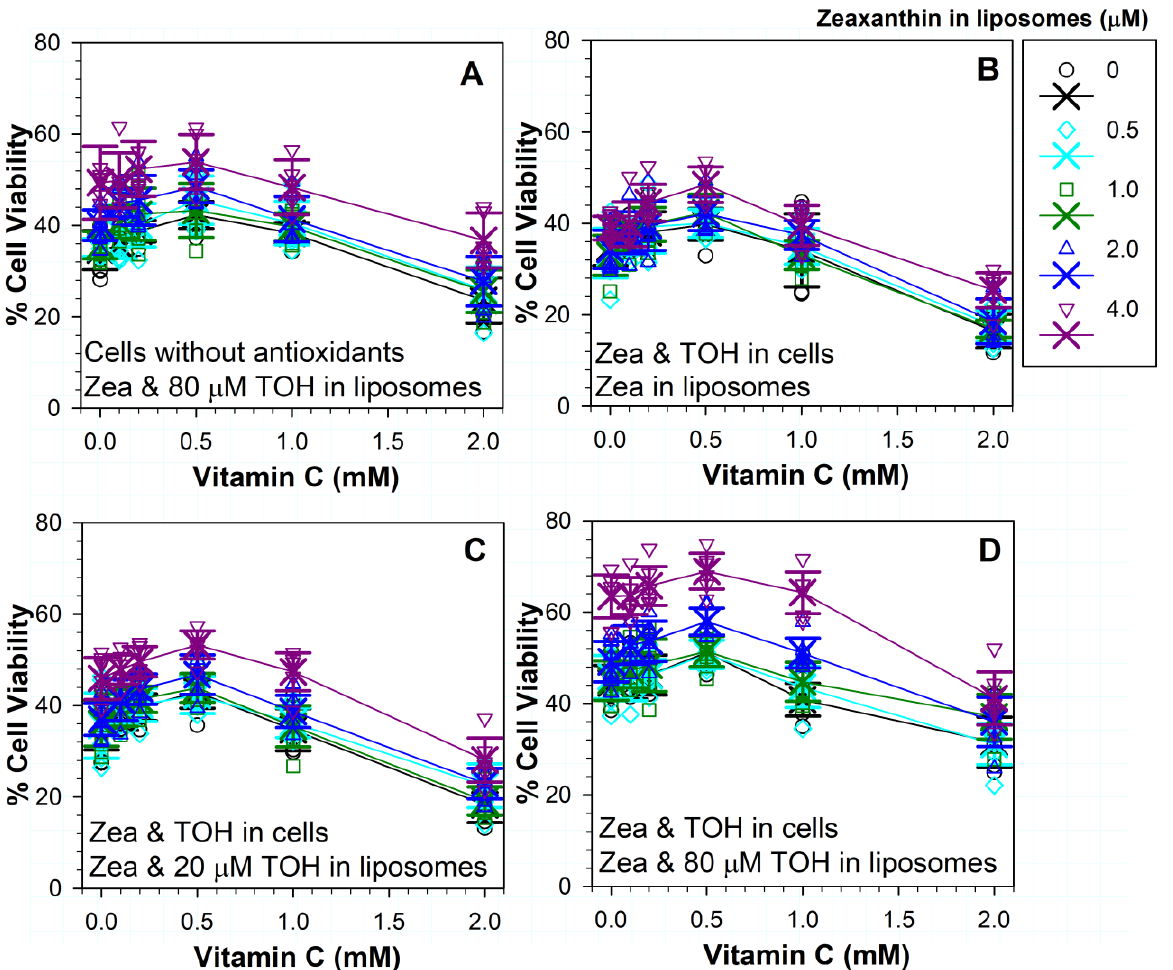
Figure 9. Effects of different combinations of three antioxidants—vitamin C, vitamin E (TOH) and zeaxanthin (Zea)—on the survival of ARPE-19 cells after exposure to visible light and liposomes containing 0.5 mM ATR with and without antioxidants. ( A ) Cells not supplemented with antioxidants, liposomes contained 80 µ M α -tocopherol and different concentrations of zeaxanthin indicated in the legend. ( B – D ): cells supplemented with α -tocopherol and zeaxanthin liposomes contained the indi- cated concentrations of zeaxanthin in the absence ( B ) and presence of α -tocopherol at concentrations of 20 µ M ( C ) and 80 µ M ( D ). Cell viability was measured by MTT assay 24 h after the exposure. The symbols represent data from individual experiments, crosses represent the means, while the error bars show SDs. The individual data points from experiments with no antioxidants in liposomes are shown only in Figure 3; N for experiments with antioxidants in liposomes and without ascorbate was 8; N for experiments in the presence of ascorbate was 6). Other experimental conditions as in Figure